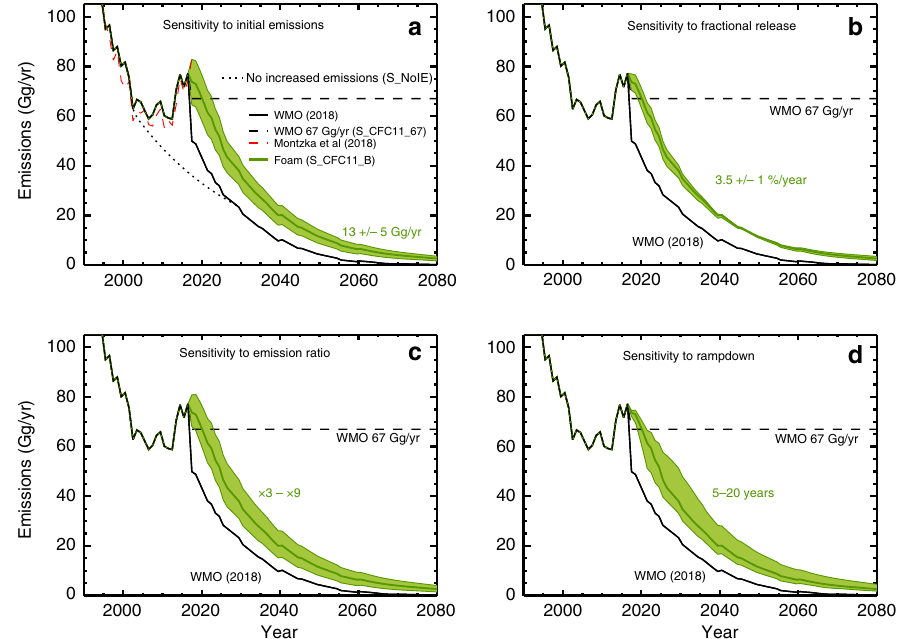
Fig. 1 Past and potential future emissions of CFC-11. Estimated emissions of CFC-11 for the past derived from atmospheric measurements and for future scenarios with different assumptions. a Five scenarios including the World Meteorological Organisation (WMO) (2018) 20 baseline scenario (solid black line) and an assumption of constant 67 Gg yr − 1 emissions (dashed line, S_CFC11_67). Also shown is a scenario with decreasing emissions from an estimate of the 2002 bank (dotted line, S_NoIE). Emissions based on box model simulations for unreported CFC-11 production for foam use are shown in green (solid line, S_CFC11_B). The green shading indicates the sensitivity range for S_CFC11_B for initial emissions ranging from 8 to 18 Gg/yr (see Methods for assumptions). b Similar to panel a , for WMO (2018) baseline and S_CFC11_67 scenarios with green shading showing sensitivity of scenario S_CFC11_B for fractional release ranging from 2.5 to 4.5%/year. c Similar to panel b , and showing sensitivity to emission ratios from ×3 to ×9. d Similar to panel b , and showing sensitivity to rampdown of new production between 5 and 20